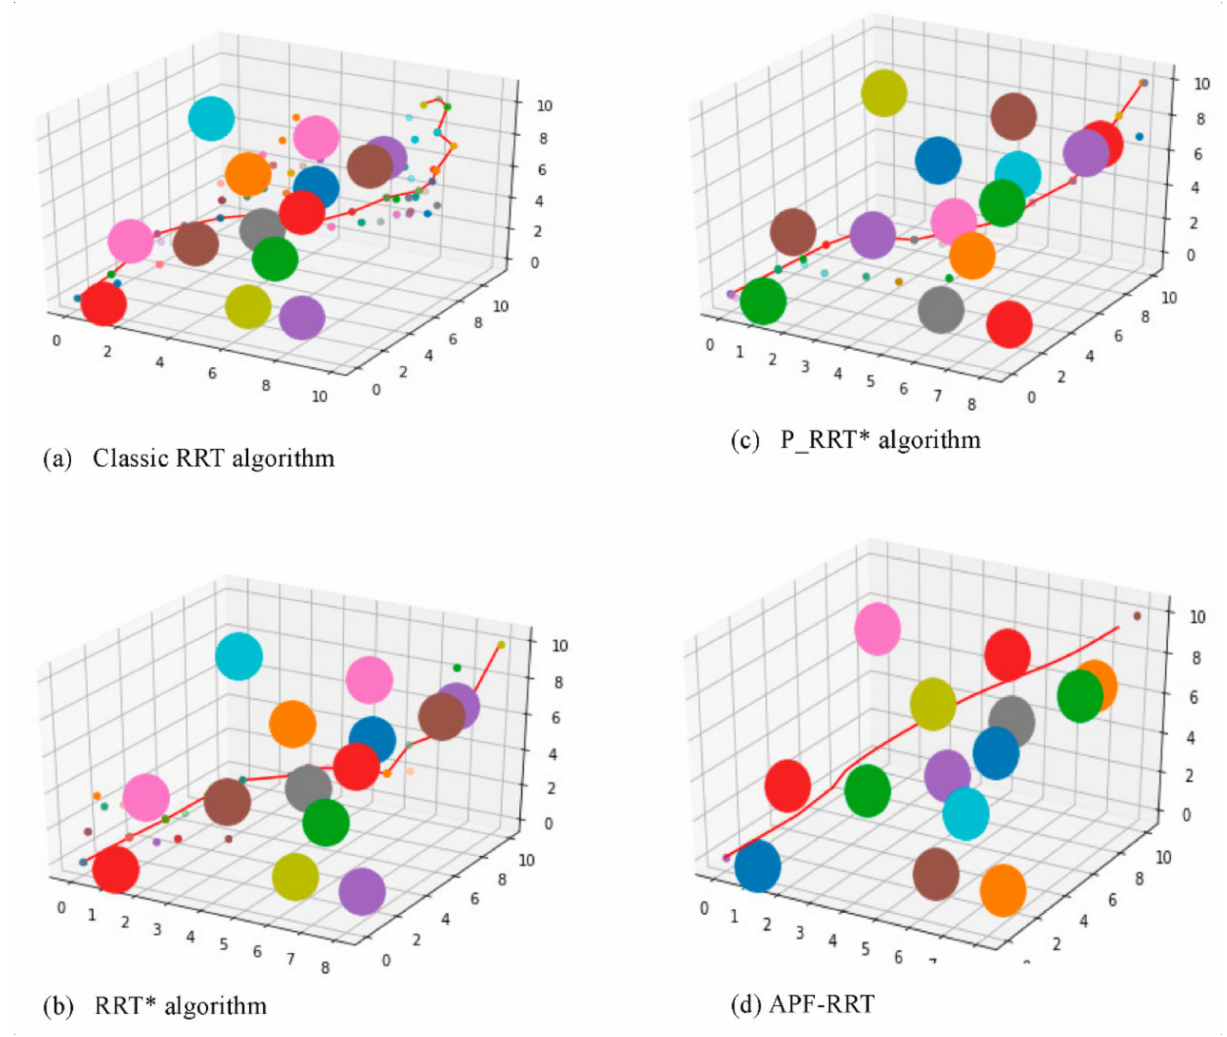
Figure 10. Comparison of paths generated by the different algorithms under the same conditions, such as the number of obstacles and step lengths.